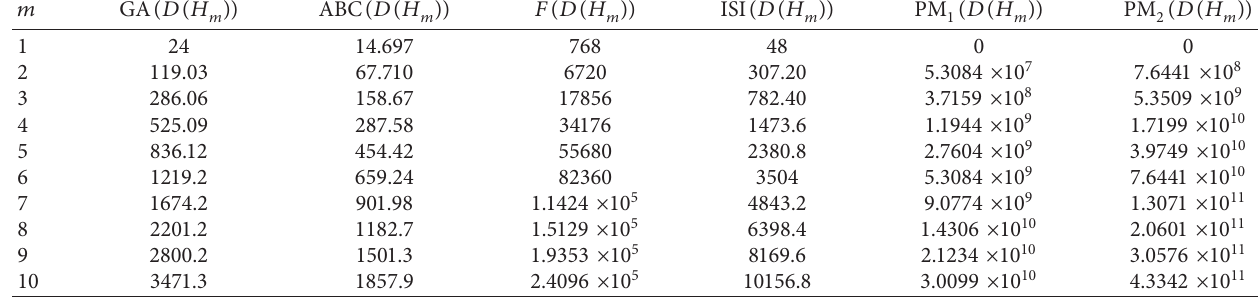
Table 2: Computation of topological indices of double graph of circumcoronene series of benzenoid ( D ( H